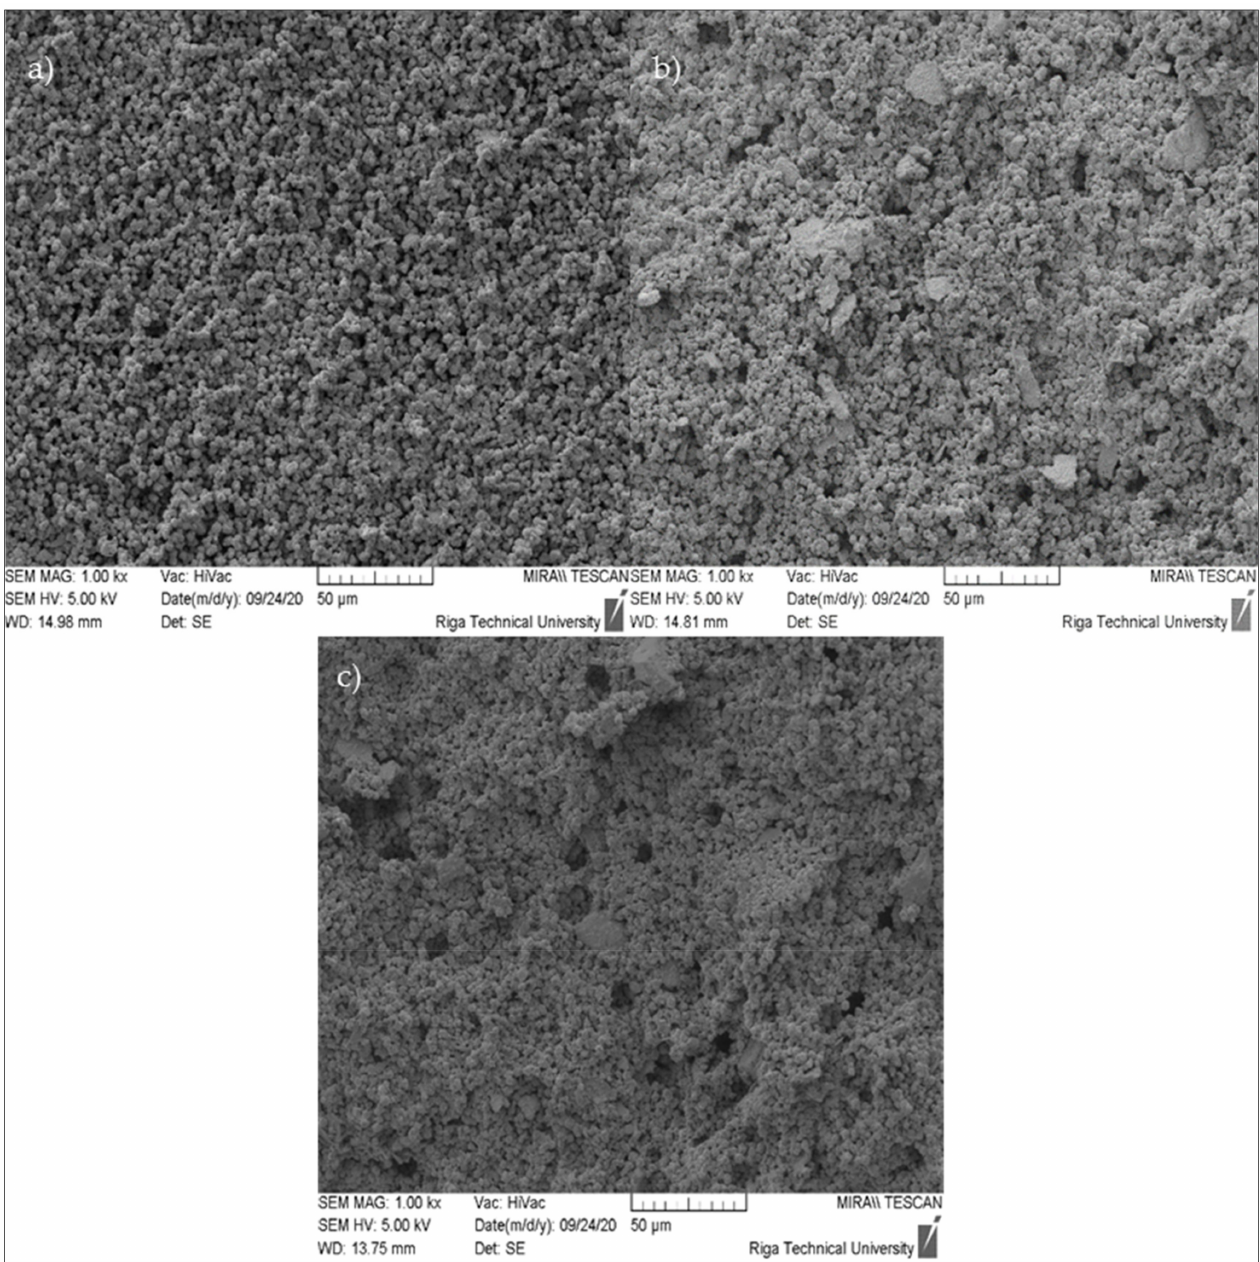
Figure 12. SEM micrographs of ZG samples (cross-section) at 1000 × magnification: ( a ) ZG-0.8; ( b ) ZG-1.0; ( c ) ZG-1.2. The produced zeolite granule microstructure, at a magnification of 5000 × , can be observed in Figure 13. The figure shows a large number of cubic crystalline formations, corresponding to the results of the XRD for zeolite 4A, as well as plate-like formations corresponding to the N-A-S-H